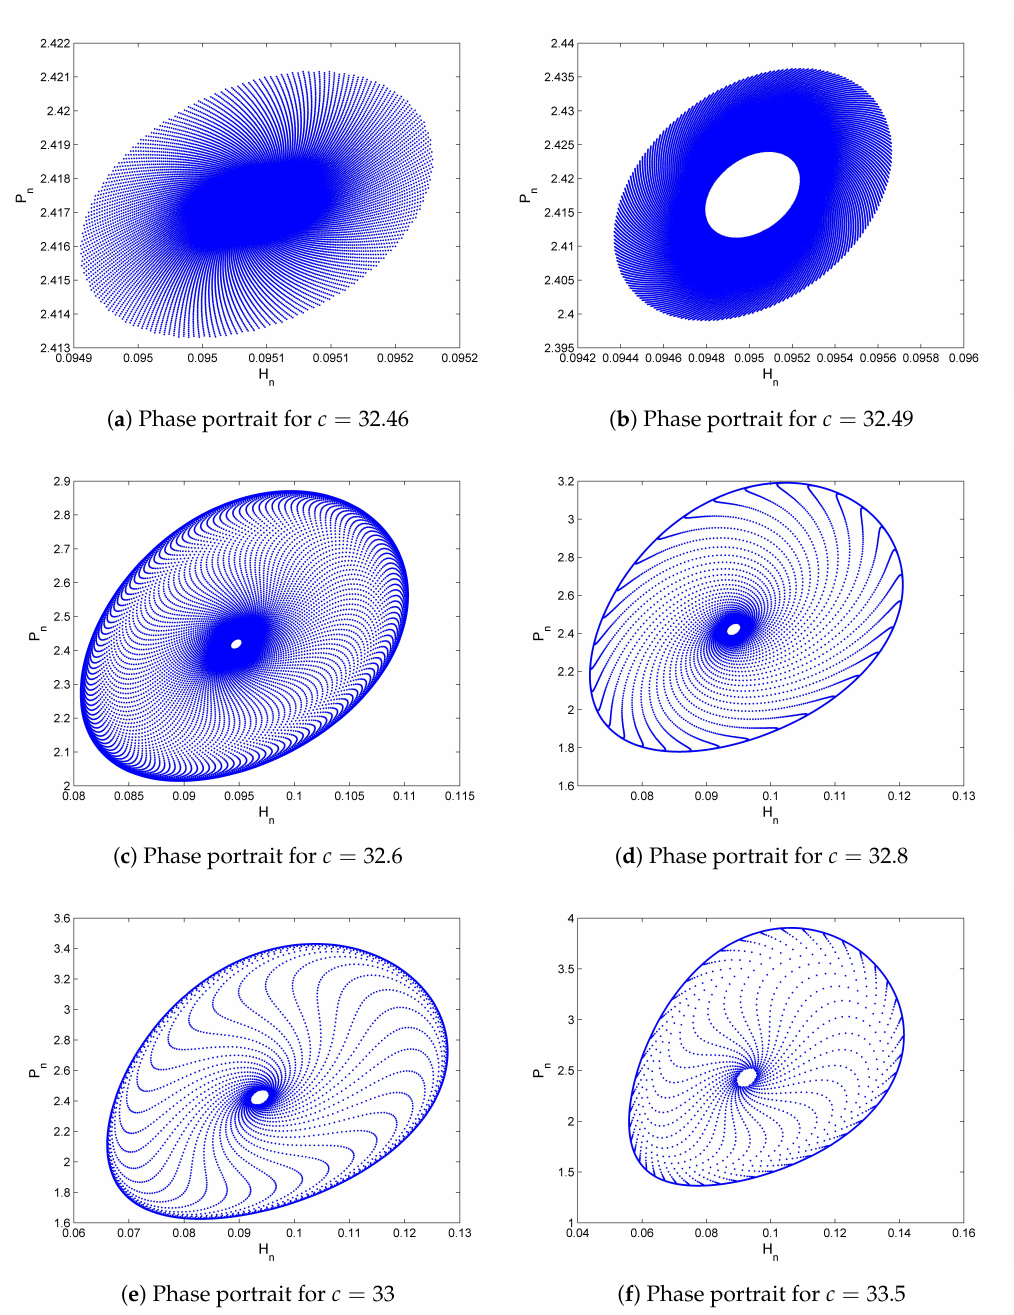
Figure 4. Phase portraits of System (7) for different values of c with ( r , q , m , k ) = ( 5.4,0.9,0.4,8.3 ) and initial conditions ( H 0 , P 0 ) = ( 0.0952,2.416 )